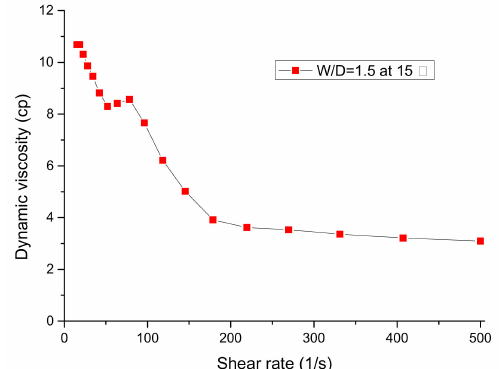
Figure 4. Viscosity changes of W:D = 1.5 emulsion as the shear rate rose at an ambient temperature of 15 ◦